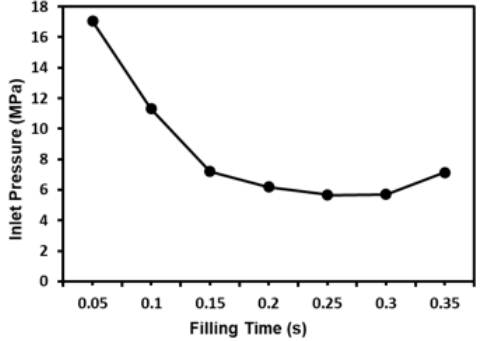
Figure 7. Correlation between inlet pressure and filling time.